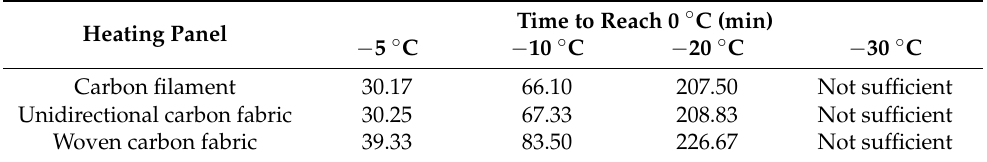
Table 1. Amount of time to reach 0 °C with three different heating panels. Reprinted with permission from [91].